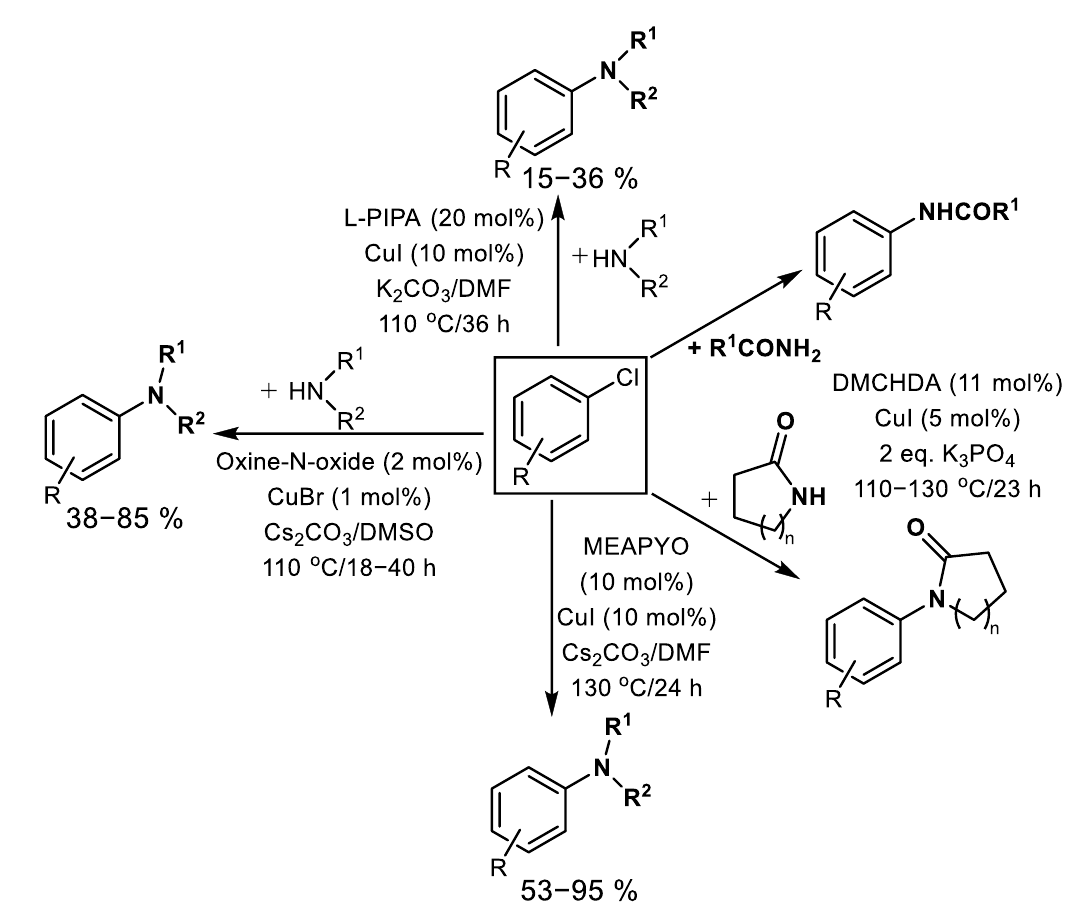
BTMPO Figure 6. Structures of another highly effective oxalic acid diamide- and benzoin oxime-based lig- ands